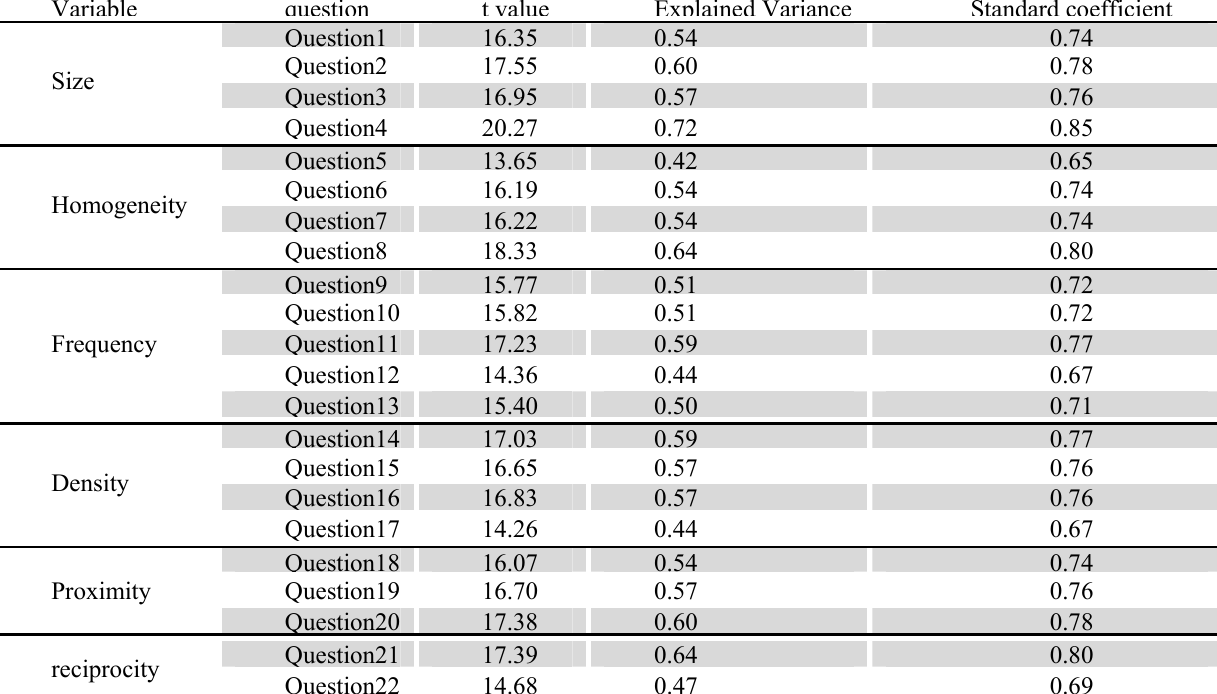
The summary of testing online social network